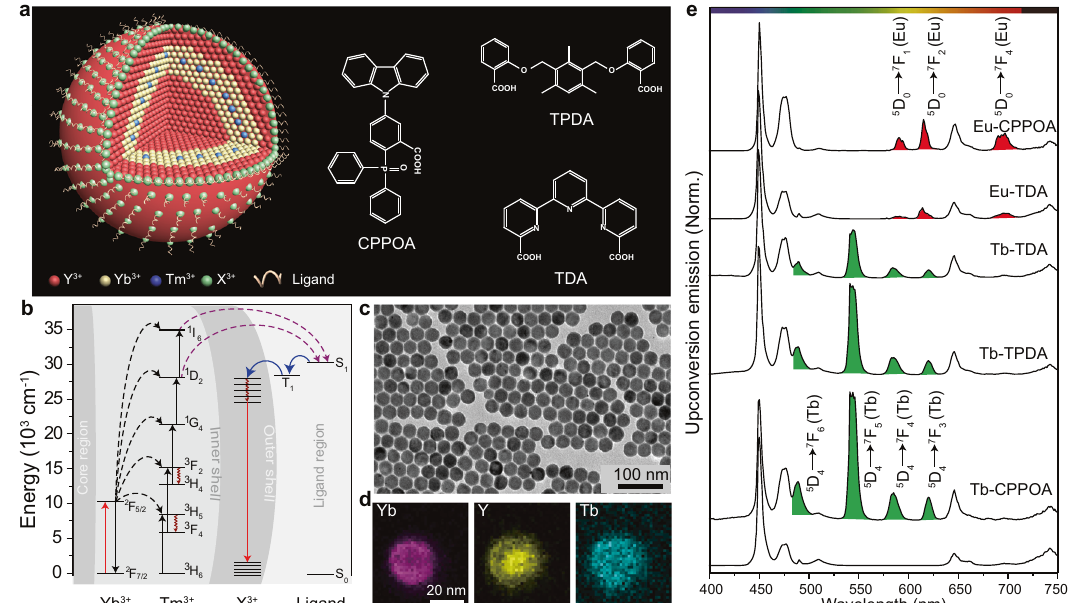
Fig. 1 Photon upconversion through triplet exciton-mediated energy relay. a Nanoparticle design (NaYF 4 @NaYbF 4 :Tm@NaYF 4 :Tb) and ligand molecules used for nanoparticle conjugation. X 3 + refers to lanthanide emitters. b The proposed energy transfer mechanism underlying photon upconversion in ligand- modi fi ed nanoparticles. Note that core, inner shell, outer shell, and surface region are highlighted with different background colours. Yb 3 + ions fi rst harvest the excitation light and then populate Tm 3 + ions. The energy transfer from the high-lying excited states of Tm 3 + ions to singlet states (S 1 ) of surface ligand via a Förster resonance energy transfer. Subsequently, triplet states (T 1 ) are formed through intersystem crossing. Finally, the excited energy is transferred to lanthanide emitters (X 3 + ) on the nanoparticle surface. c Transmission electron microscopy imaging of as-synthesized nanocrystals. d Elemental Yb, Y, and Tb mapping of a selected nanoparticle. e Photoluminescence spectra of NaYF 4 @NaYbF 4 :Tm@NaYF 4 :X (X: Tb 3 + or Eu 3 + ) nanoparticles with and without surface ligands (980-nm excitation, 507 W/cm 2 ). Tb 3 + emission peaks are shown in green and Eu 3 + emission peaks in